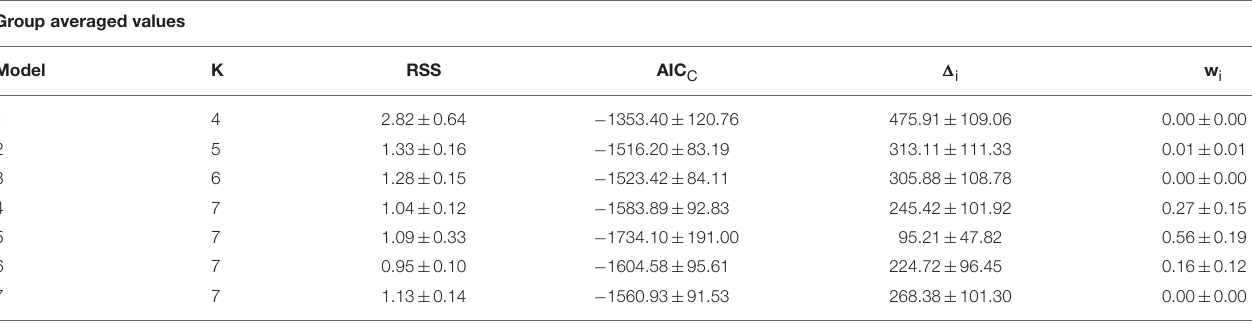
TABLE 2 | Comparison of model fits with different free parameters. Group averaged values